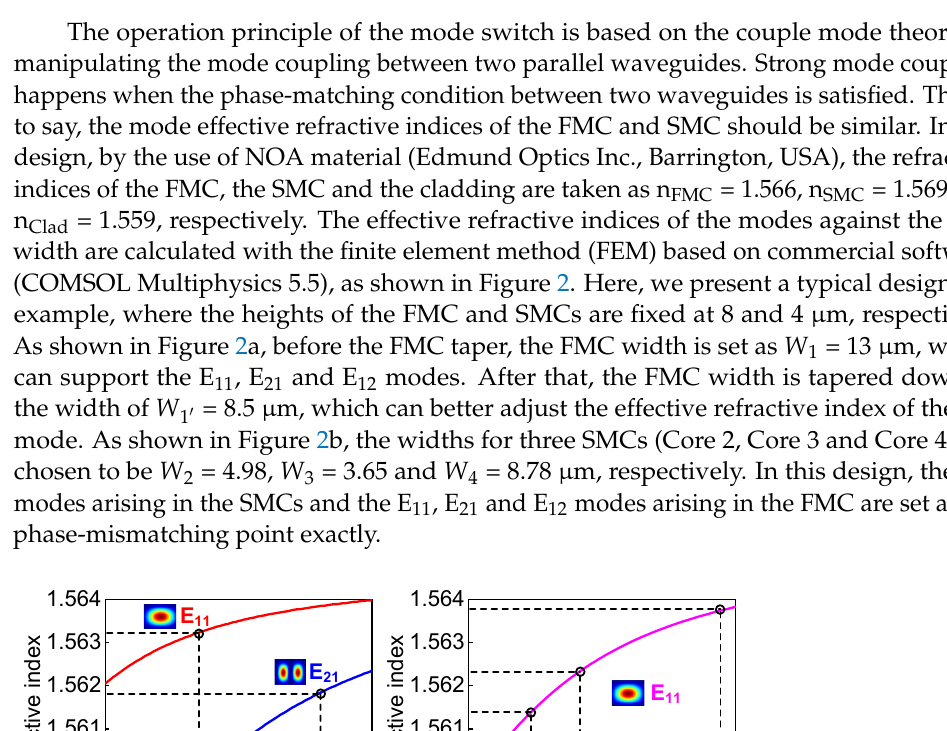
Figure 1. Schematic diagram of the proposed device, where monolayer graphene is attached on the surface of the SMCs; the operation states of the device with switch are set at ( a ) OFF state and ( b ) ON state.